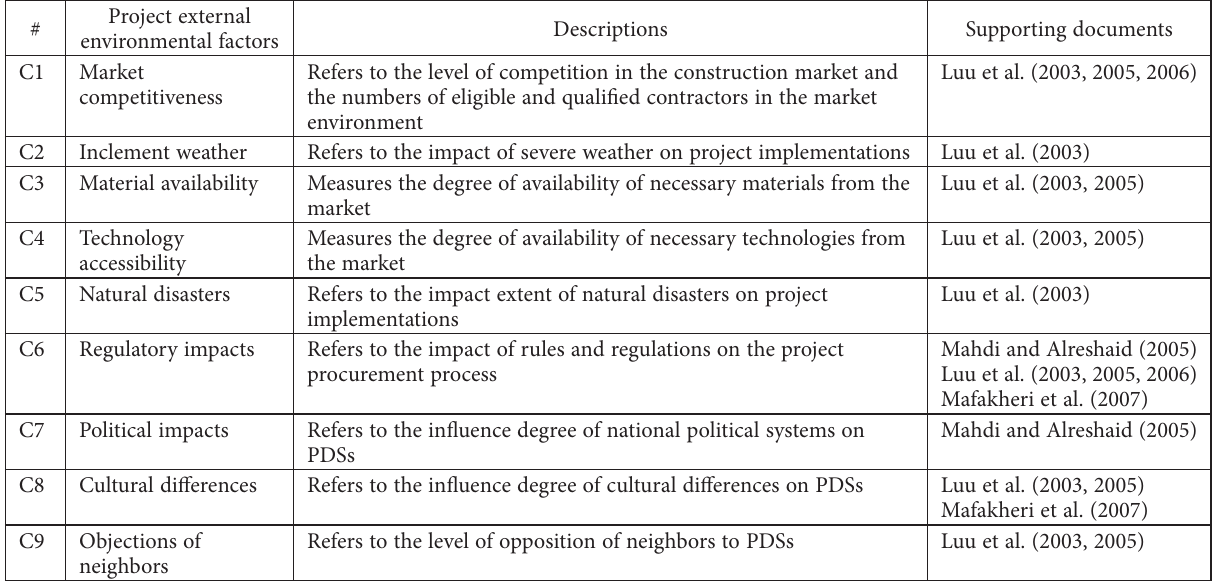
Table 1. Project external environmental factors that affect the decision-making of